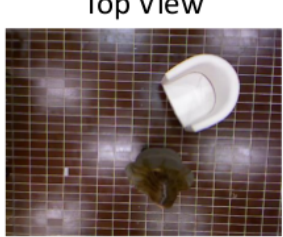
Figure 1. The setup consists of a sensor placed on the ceiling of the laboratory at a height of 3 m from the floor. The subject in the picture is performing the ASSO activity of daily living